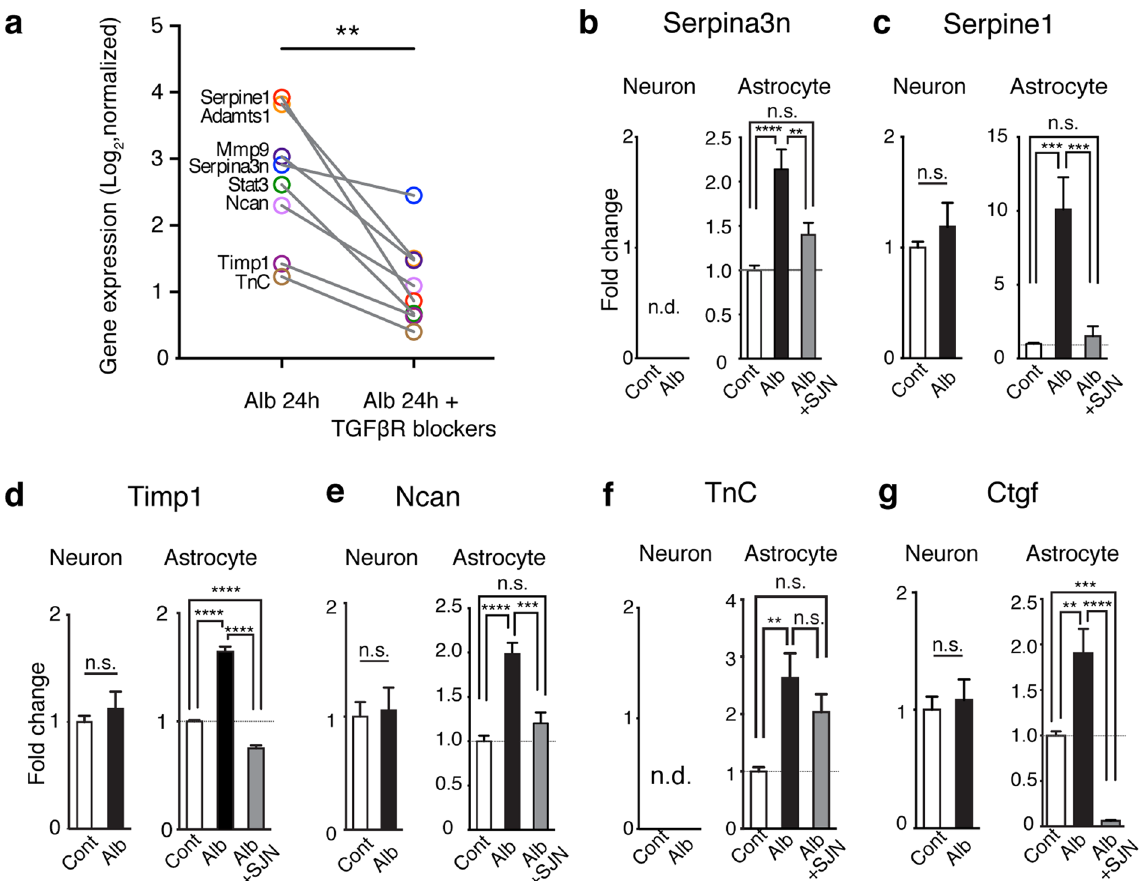
Figure 4. Albumin activated the transcriptional responses of ECM genes via TGF β receptor signaling. ( a ) The expression levels of ECM-related genes is upregulated across models (marked in bold in A, C) in a separate microarray data set in comparisons between albumin vs. albumin + TGF β receptor (R) blockers. ** p = 0.0078, Wilcoxon signed-rank test, two-tailed. ( b – g ) Quantitative real-time PCR for the mRNA expression of selected genes in primary cortical astrocytic or neuronal cultures at 24 hours following treatment of albumin or albumin plus a specific Alk5 blocker, SJN2511. Results were of three independent primary culture derivations (n = 11 per condition in neurons; n = 10–12 per condition in astrocytes). One way ANOVA with posthoc Turkey’s test (in astrocytes) and student t-test (in neurons) were performed. Cont, control; Alb, albumin; SJN, SJN2511; n.d., non detectable (Cq value ≥ 35). * p < 0.05, ** p < 0.01, *** p < 0.001, **** p < 0.0001. Data are shown as mean ±